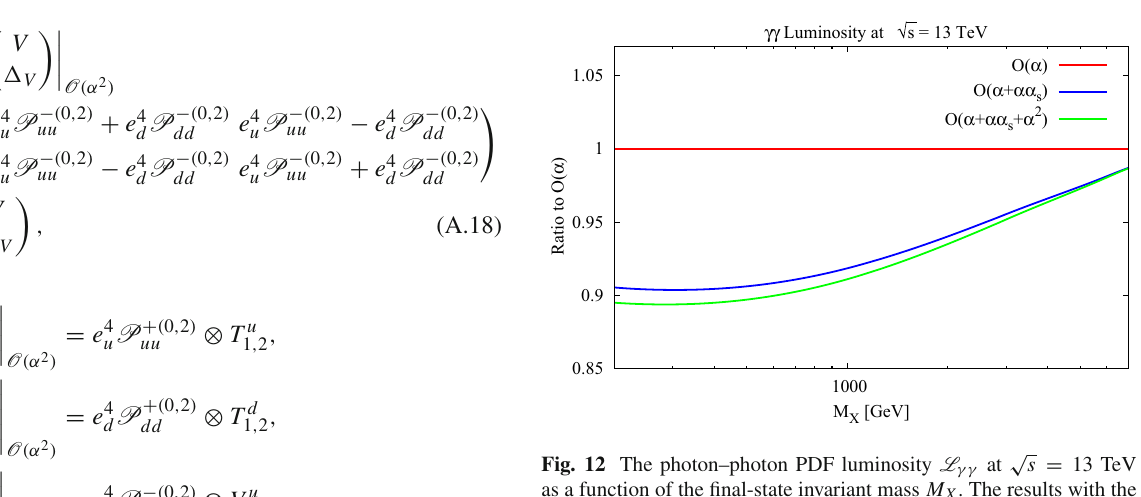
Fig. 12 The photon–photon PDF luminosity L γγ at as a function of the final-state invariant mass M X . The results with the photon evolved with only the O (α) corrections are compared with the corresponding results taking into account the O (α + α s α) corrections and the complete O (α + α s α + α 2 ) effects, normalised in all three cases to the O (α) result. The calculation has been performed using the central value of the NNPDF3.0QED NLO